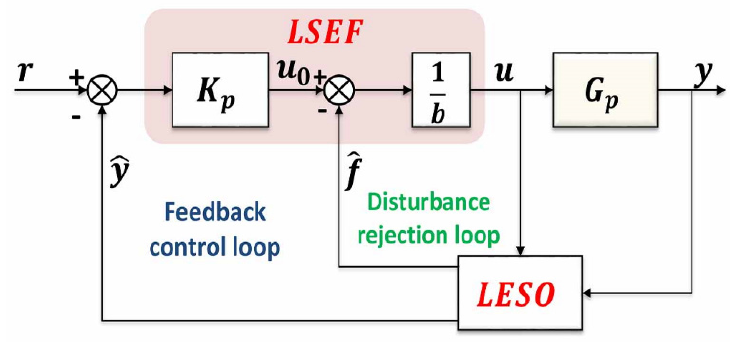
Figure 2. Structure diagram of the LADRC.